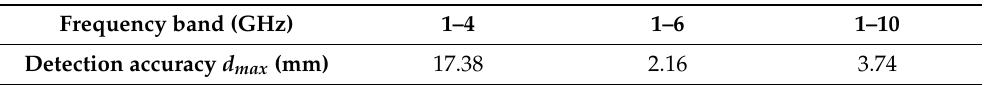
Figure 17. Effect of frequency bandwidth on imaging accuracy tested on the heterogeneous model with the catheter in position 1: ( a ) Frequency band 1–4 GHz; ( b ) Frequency band 1–6 GHz; ( c ) Frequency band 1–10 GHz. Table 3. Detection accuracy-UWB pulse frequency band optimization test.